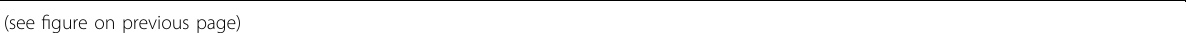
Fig. 2 CircPSMA1 promotes TNBC cell proliferation and migration and regulates cell cycle and apoptosis. A The qRT-PCR analysis of circPSMA1 expression in TNBC cells transfected with circPSMA1 overexpression vector (circPSMA1) and negative control (circ-NC). B The qRT-PCR analysis of circPSMA1 expression in TNBC cells transfected with circPSMA1 siRNA vector (si-circ) and negative control (si-NC). C – E EdU assays were carried out in TNBC cells after transfection with circPSMA1 overexpression vector (circPSMA1) or circPSMA1 siRNA vector (si-circ) (magni fi cation, ×100, Scale bar = 100 μ m). F – H Colony formation assays were conducted to con fi rm the proliferative abilities of TNBC cells that transfected with these indicated vectors. I , J The wound healing assays were carried out to detect the migration abilities of TNBC cells after transfected with these indicated vectors (magni fi cation, ×50, Scale bar, 200 μ m). K – N Transwell assays were executed to detect the migration abilities of TNBC cells after transfected with these indicated vectors (magni fi cation, ×100, Scale bar, 100 μ m). O , P Cell cycle analysis showed that circPSMA1 could regulate TNBC cell cycle and apoptosis. Q , R The apoptotic rate of TNBC cells was analyzed by fl ow cytometry after downregulation of circPSMA1 expression. Data were shown as mean ± SD at least three independent experiments, * p < 0.05, ** p < 0.01, *** p <